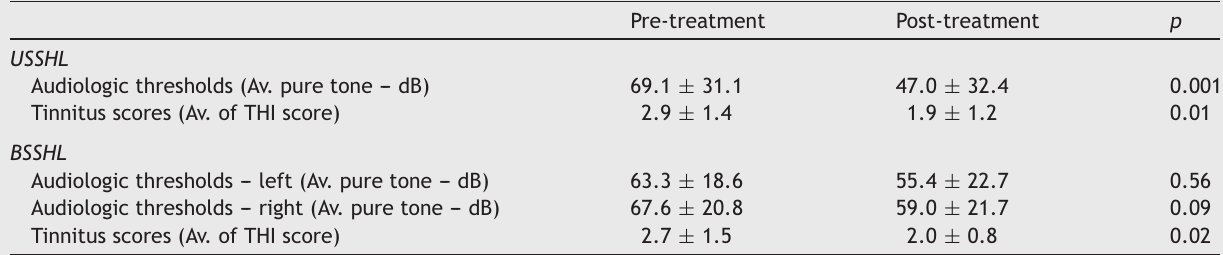
Audiologic thresholds and tinnitus scores of the patients in unilateral and bilateral SHL ( p values are in-group statistics). Pre-treatment Post-treatment p USSHL Audiologic thresholds (Av. pure tone ---